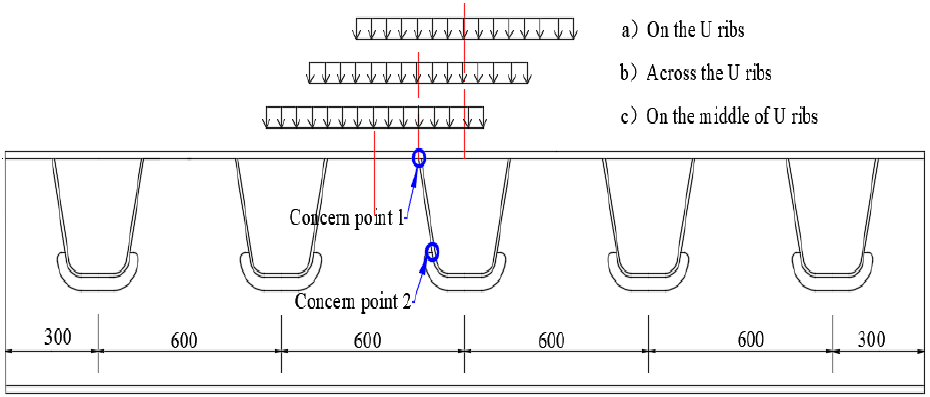
Figure 7. Transverse loading condition along the bridge (mm).